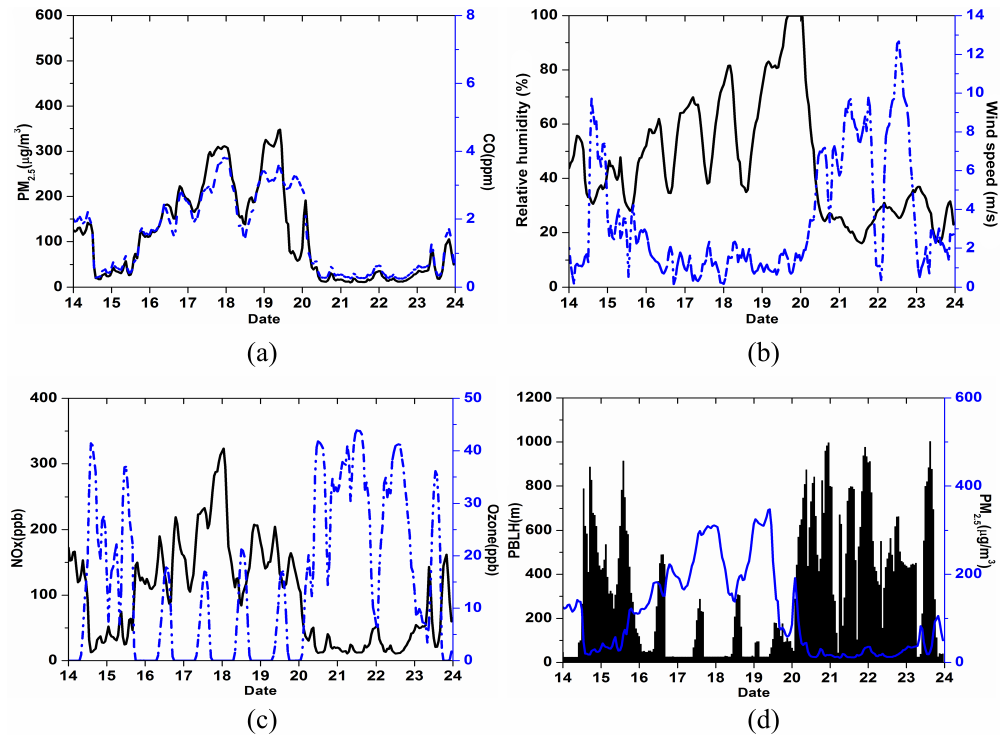
Figure 9. Simulated temporal variations of meteorological and chemical variables in